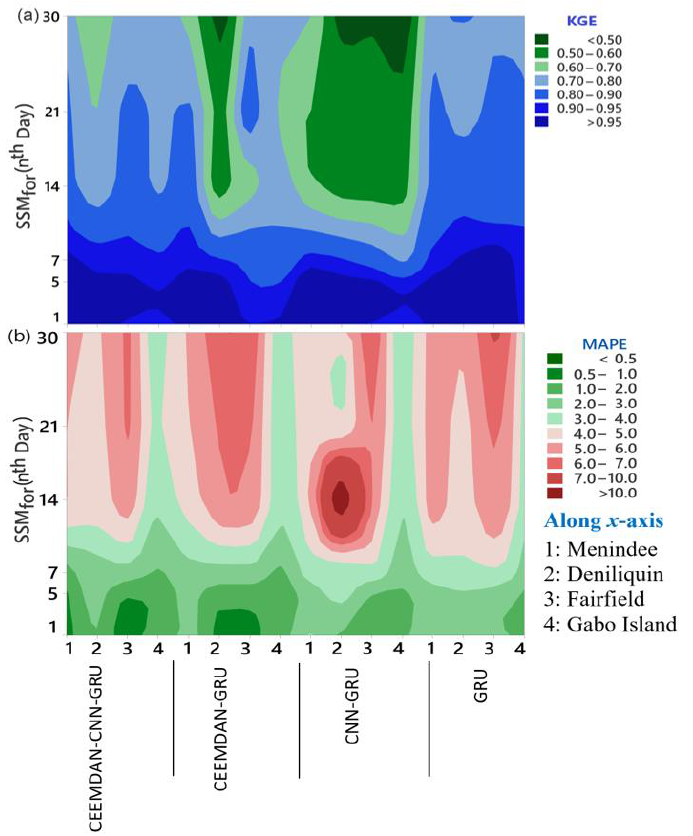
Figure 10. Contour plot of ( a ) KGE, ( b ) MAPE for hybrid CEEMDAN-CNN-GRU model against comparative models for different n th ( n = 1, 5, 7, 14, 21, and 30) day ahead forecasting of SSM.